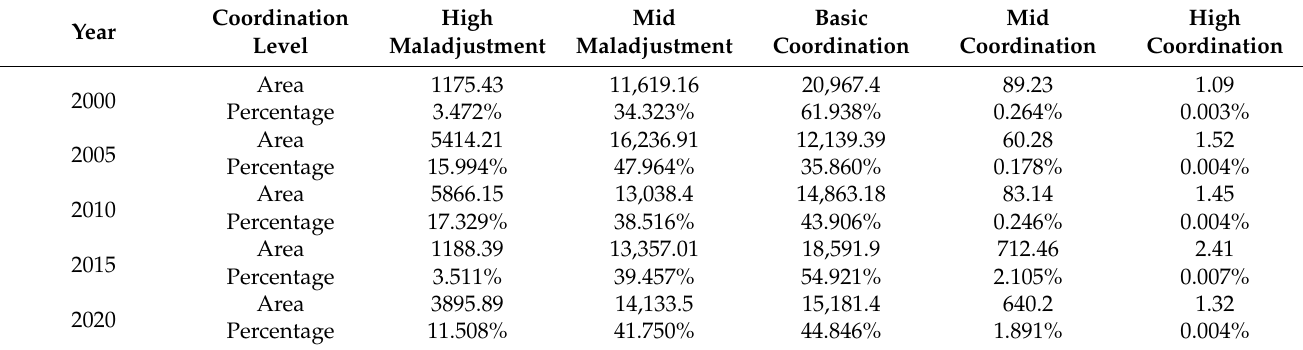
Table 12. Environmental and economic coordination index in Hainan. Coordination Index